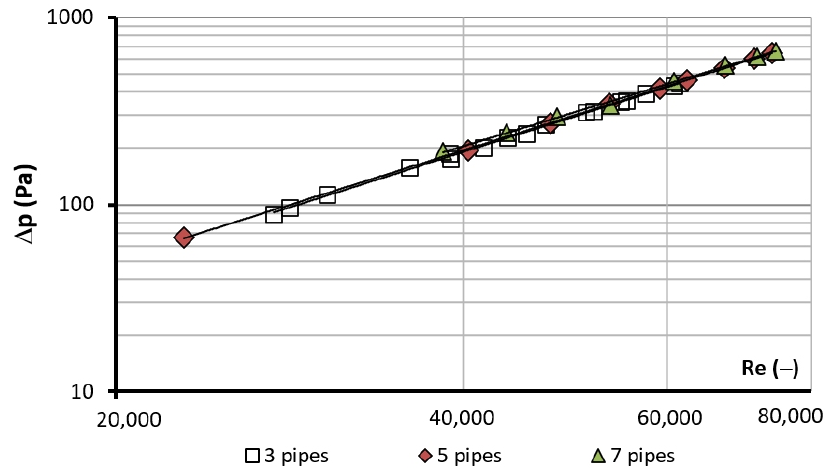
Figure 7. Comparison of flow characteristics for all investigated cases of exchangers.